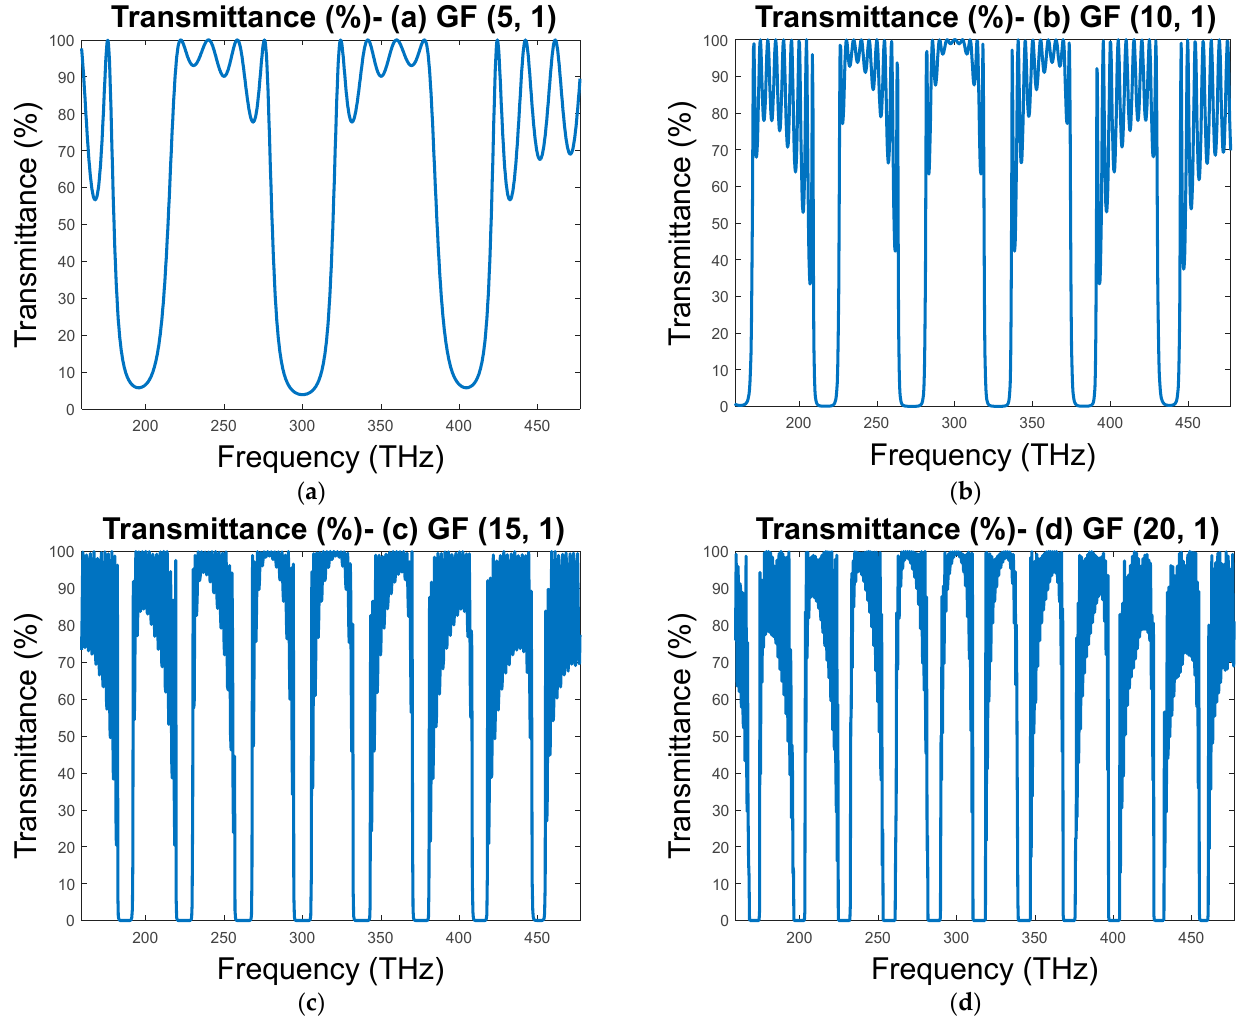
Figure 3. Transmittance spectra versus frequency for 1D GF sequence (3 rd iteration) and for ( a ) GF (5, 1), ( b ) GF (10, 1), ( c ) GF (15, 1), and ( d ) GF (20, 1).